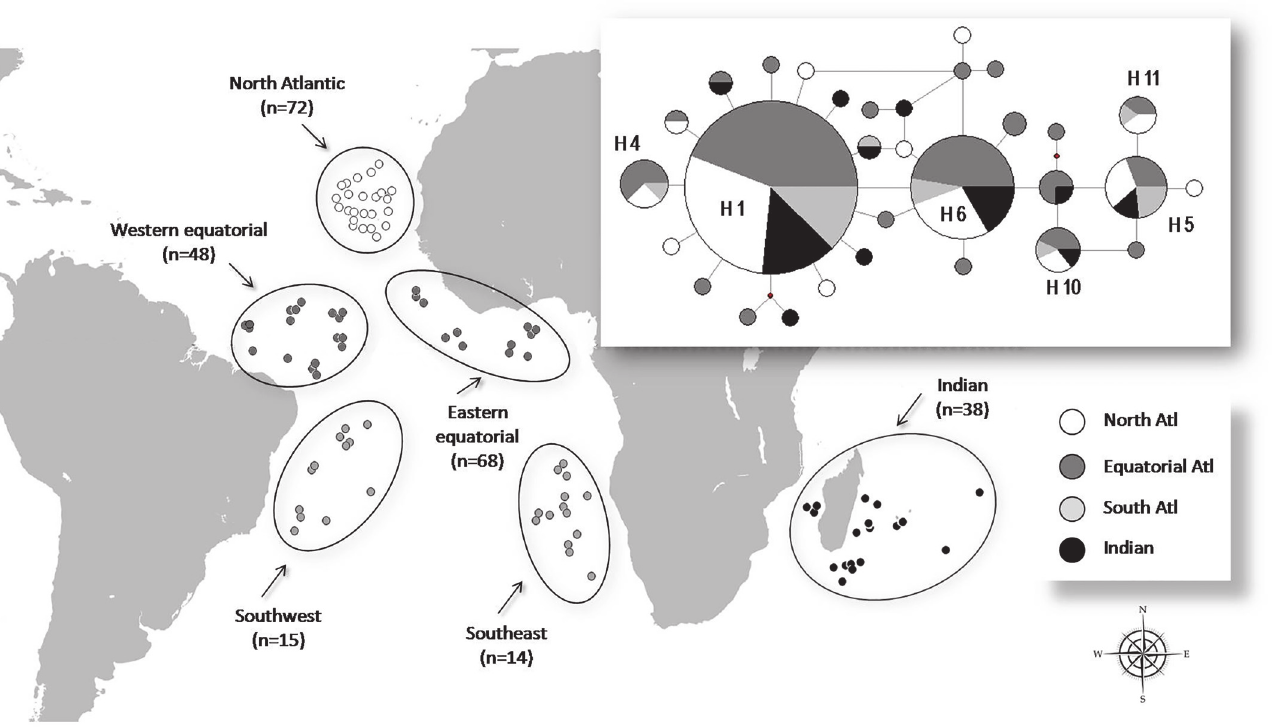
Fig 1. Geographic distribution of samples of P. kamoharai , with the network of haplotypes analyzed and compiled from the sequences of the mitochondrial DNA control region. Intermediate points in the network of haplotypes represent hypothetical haplotypes not sampled. All haplotypes differ by only a single mutation in the network, and the sizes of the circles are proportional to their